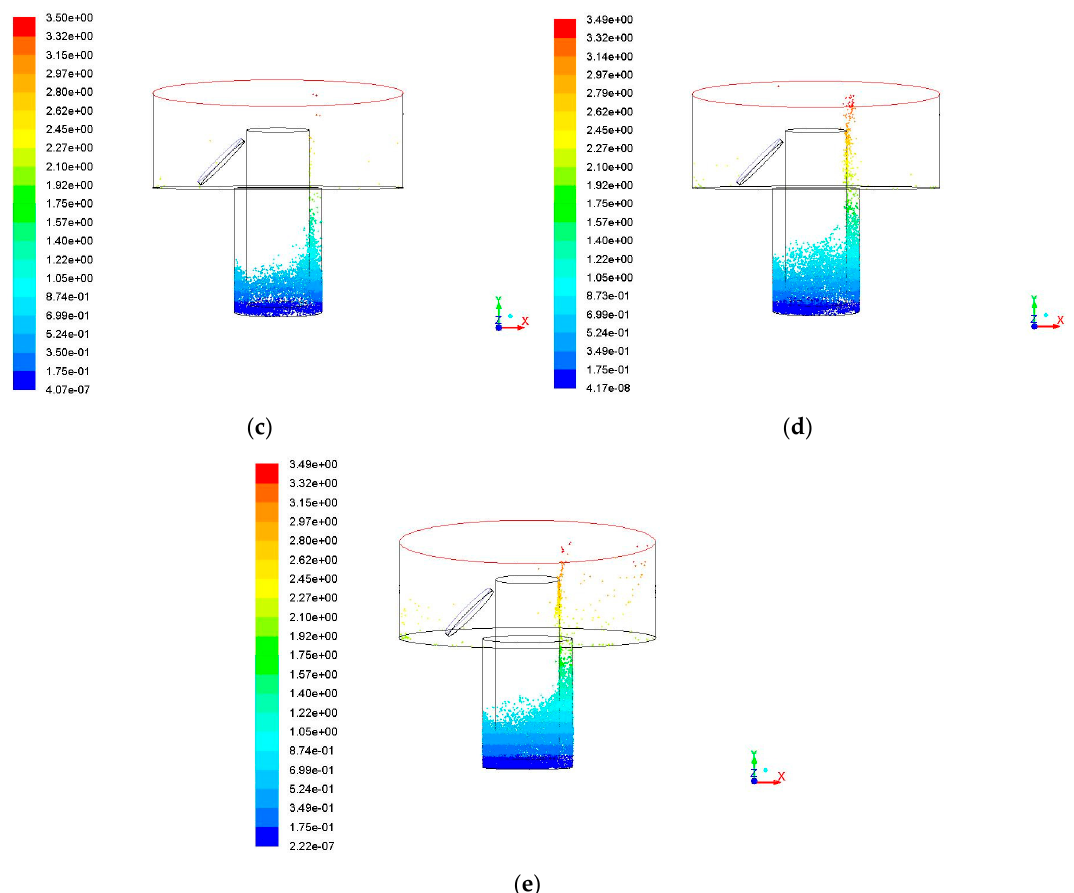
Figure 11. The debris movement with time when the hole depth is 2 mm, amplitude is 5 μ m, frequency is 20 kHz. ( a ) Initial debris distribution; ( b ) Debris distribution at 0.01 s; ( c ) Debris distribution at 0.02 s; ( d ) Debris distribution at 0.03 s; and, ( e ) Debris distribution at 0.04 s.